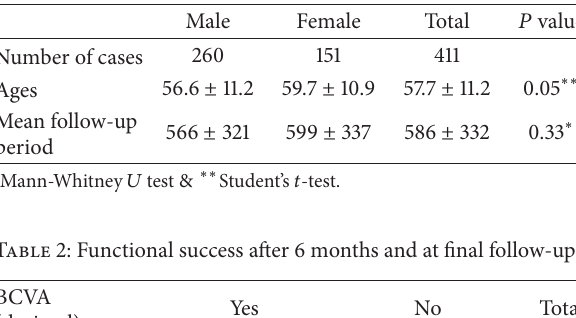
Table 1: Demographics of the patients in the study.